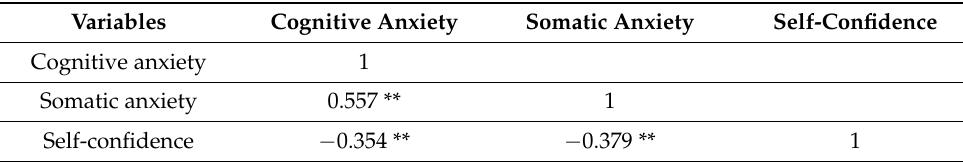
Table 10. Analysis of correlations between